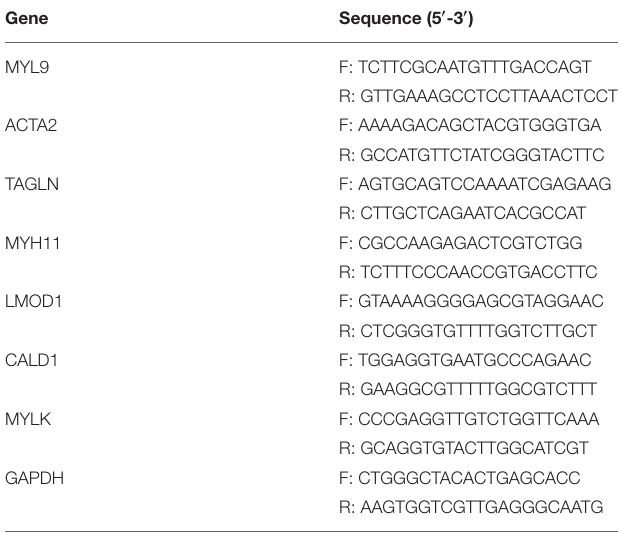
TABLE 1 | Primer sequences used for RT-qPCR.